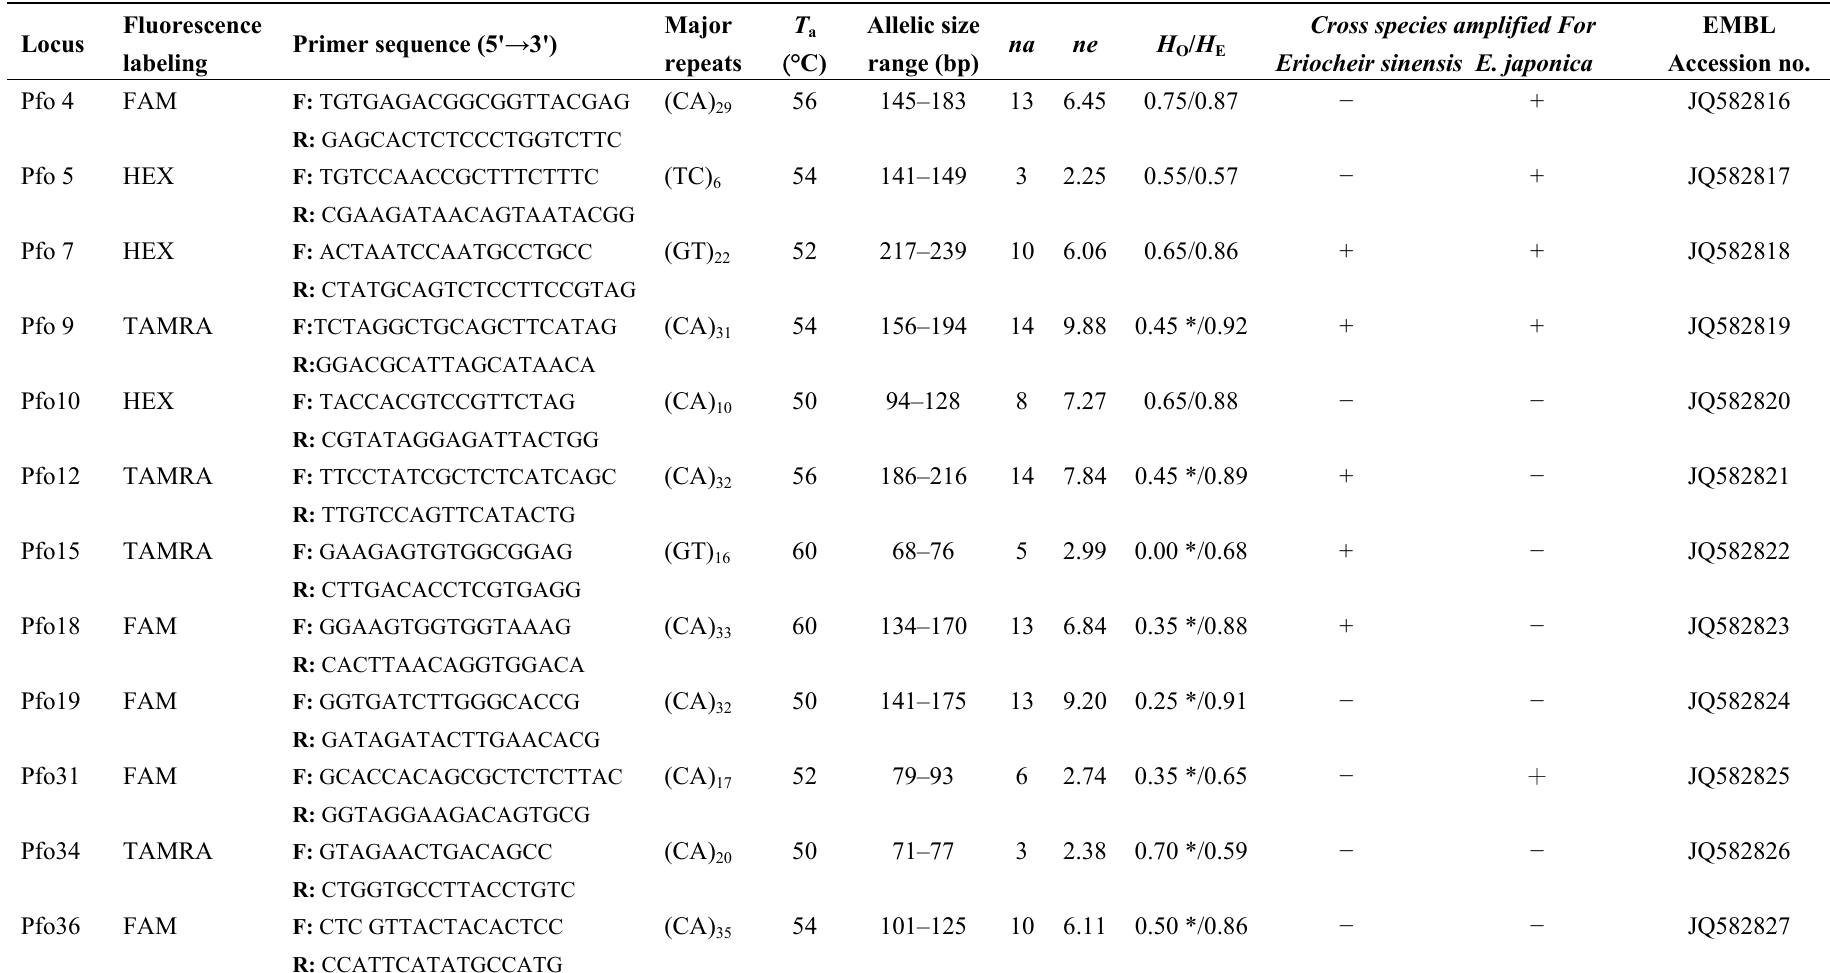
Table 1. Primer sequences, characterization of the core region, and levels of genetic variation at 18 microsatellite loci from Platyeriocheir formosa